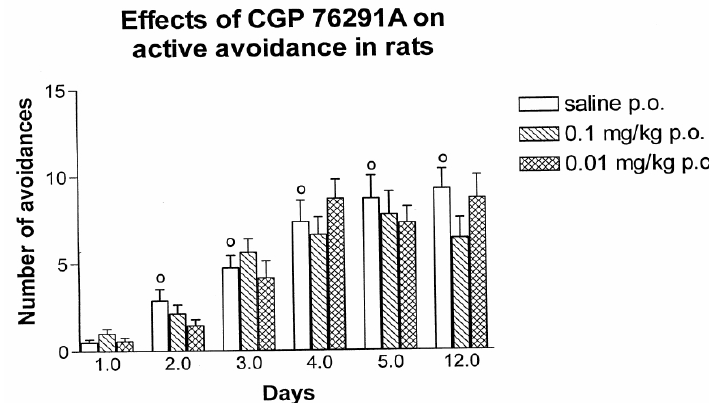
Fig. 2 Effects of the GABA B receptor antagonist CGP76291 on learning and memory processes in active avoidance test.